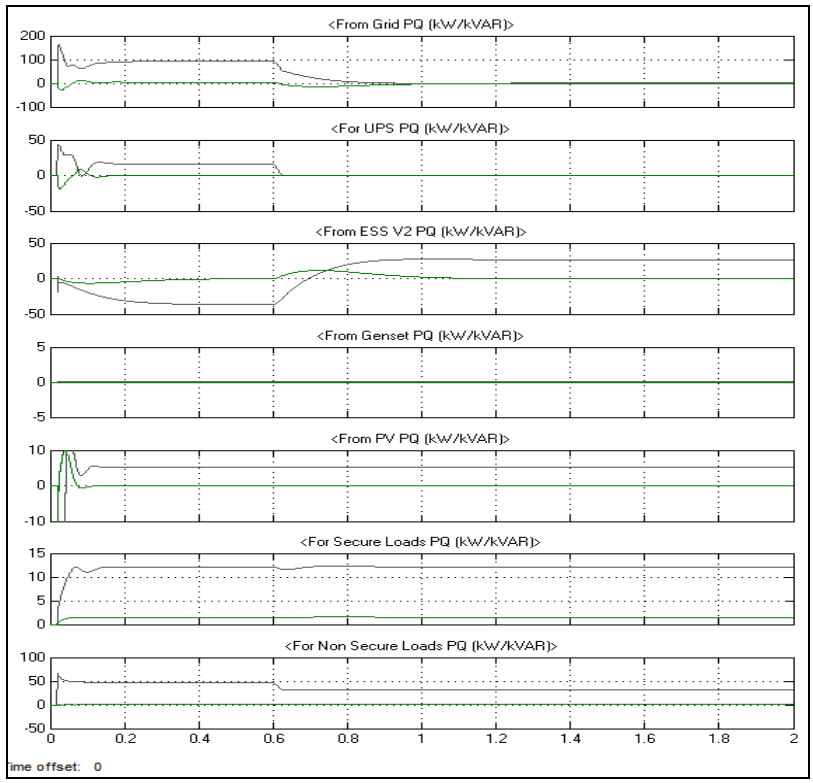
Figure 15. Simulation results in On Grid mode during low cost of energy tariff.